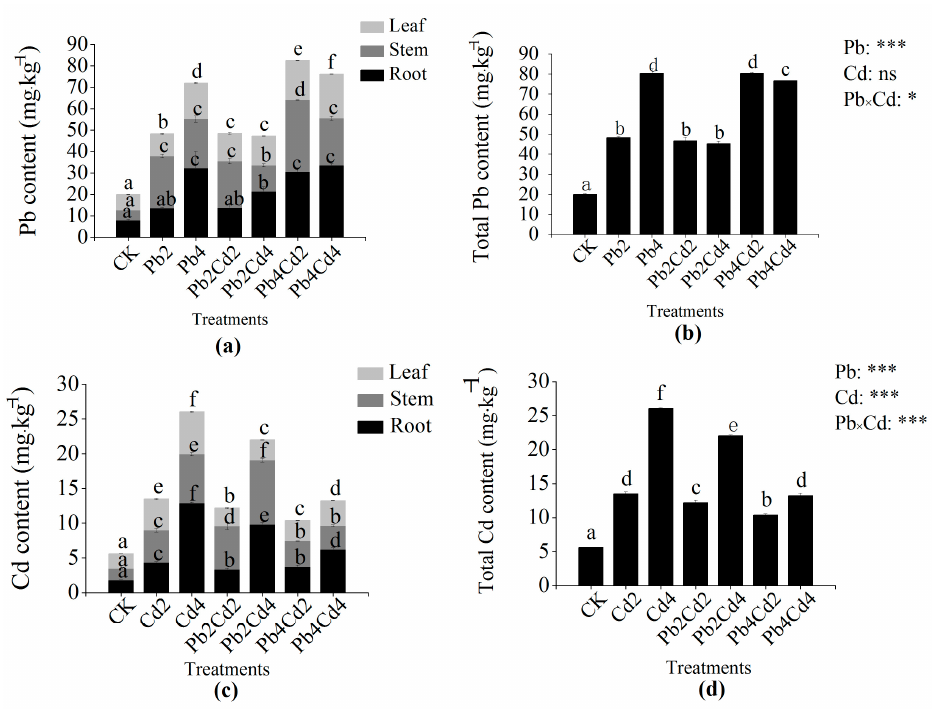
Figure 3. Effects of individual and combined Pb and Cd stress on Pb and Cd content of F . parvifolia . ( a ) The Pb content of plant different tissues. ( b ) The total Pb content in the plant. ( c ) The Cd content of plant different tissues. ( d ) The total Cd content in the plant. The post hoc test used for the estimation of the significance level is the Duncan test. Different lowercase letters indicate significant differences at p < 0.05 between treatments. Each value represents mean values ± SEs (n = 5). ns, p > 0.05; *, p < 0.05; ***, p <